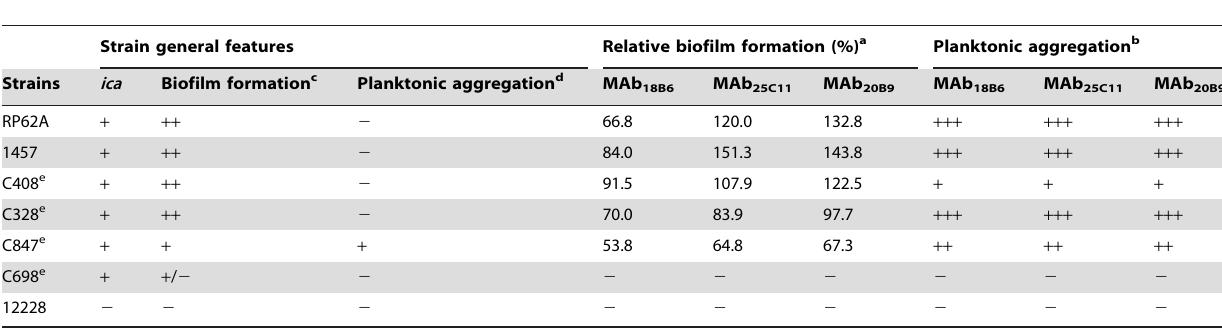
Table 4. Effects of anti-AapBrpt1.5 MAbs on different S. epidermidis